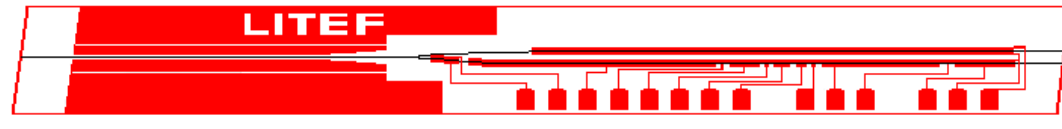
Figure 6. Waveguide and Electrode structure of a mixed signal 12-bit MIOC.